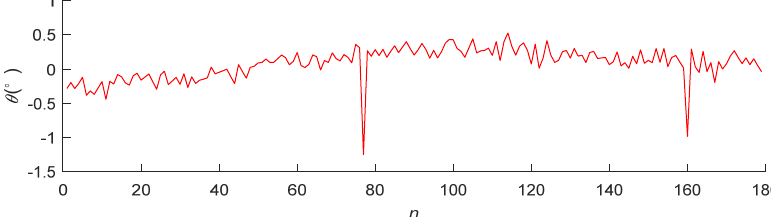
Figure 28. Angle detection error of the pose measurement system.